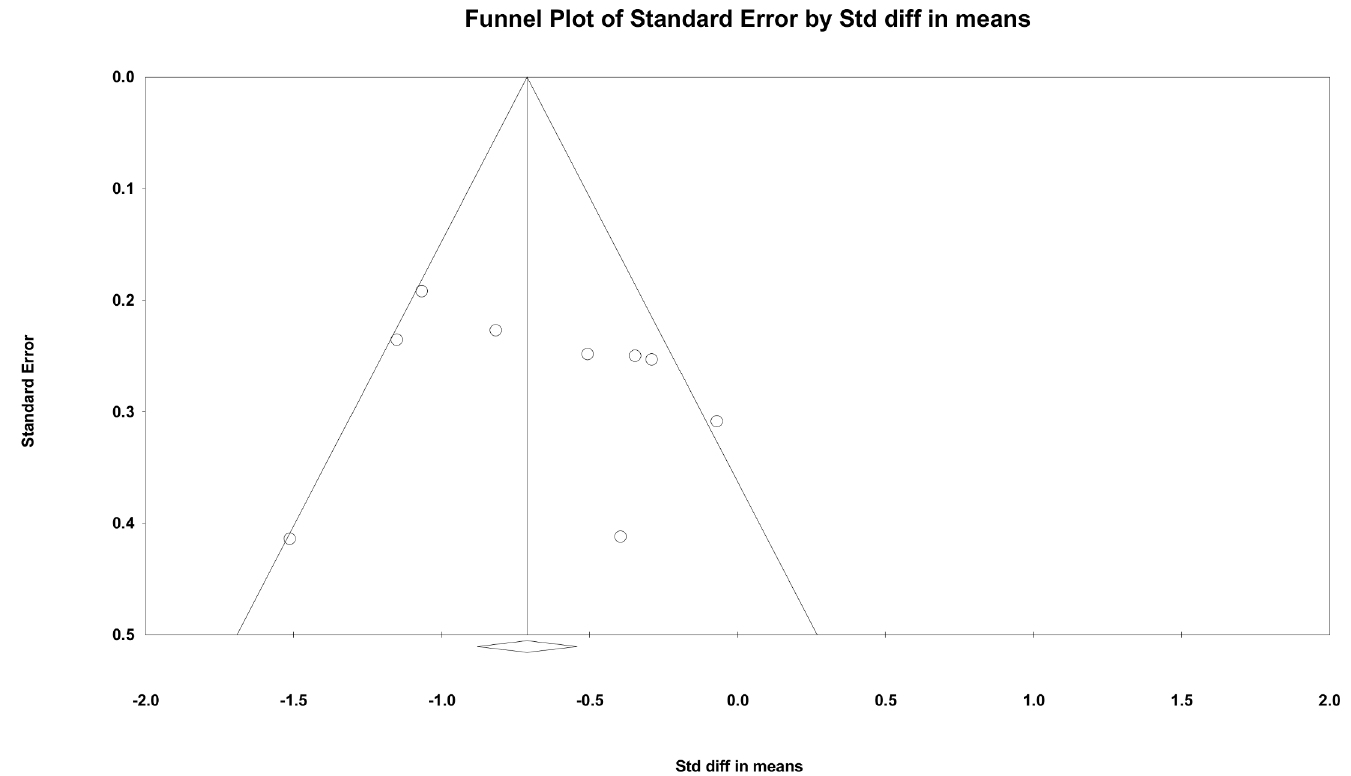
Fig 3. ECT added to non-clozapine antipsychotic medications for treatment resistant schizophrenia: publication bias.